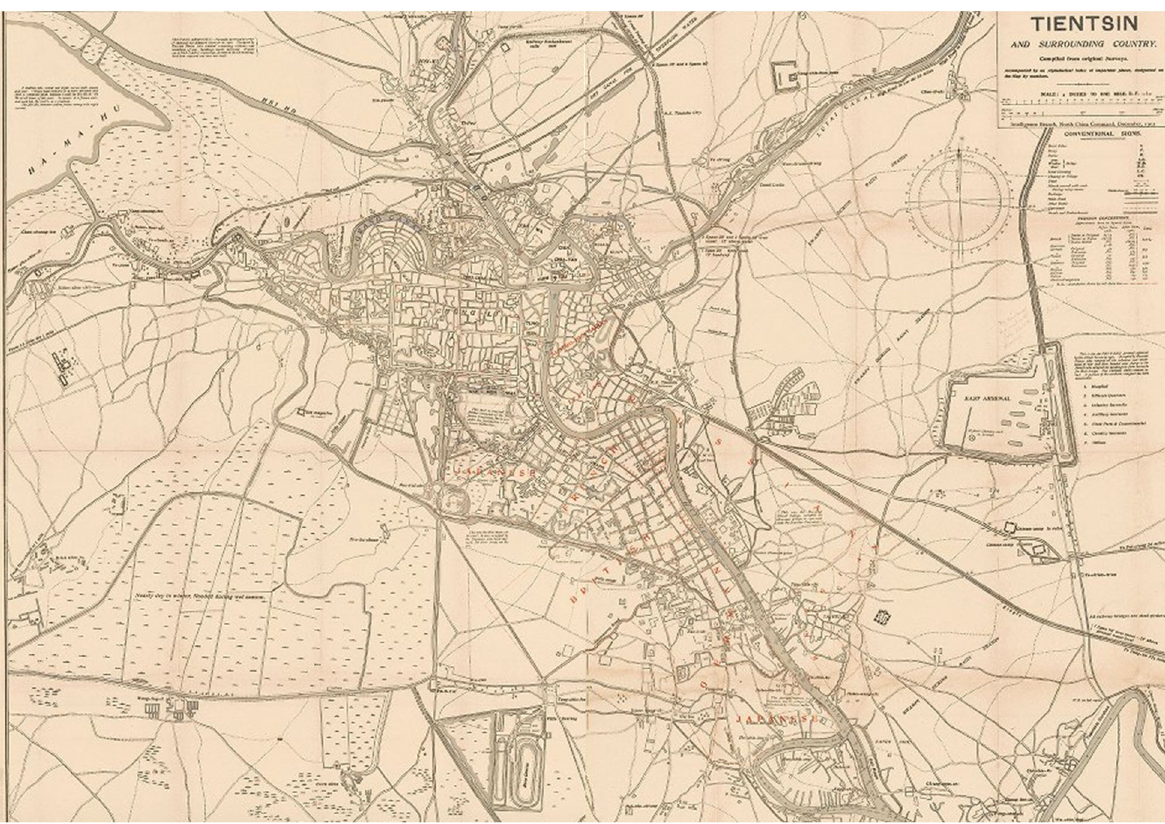
Fig. 1 Map of Tianjin and surroundings, 1903 (Source: https://www.lib.uchicago.edu/e/collections/maps/asian-cities/G7824-T5-1903-G7-W.html)